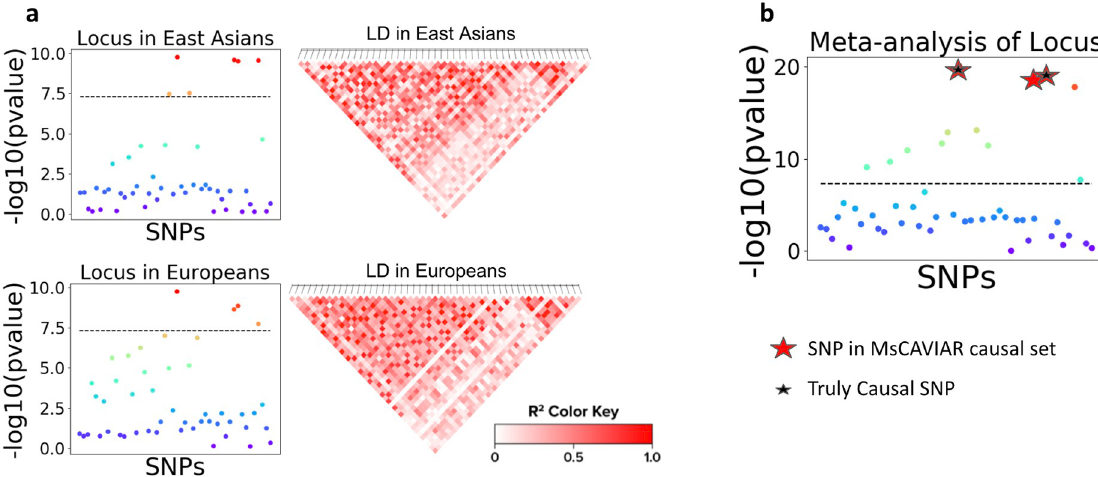
Fig 1. Overview of MsCAVIAR. (A) Simulated Z-scores for SNPs at a quantitative trait locus in two different populations: East Asians (top) and Europeans (bottom), shown by their − log 10 (p-value). LD matrices for these populations were derived using data from the 1000 Genomes project. These are the input files to MsCAVIAR. (B) Meta-analysis results for this locus, showing many significant SNPs. Also displayed are the SNPs that are in the causal set that MsCAVIAR returns (red stars) and the truly causal SNPs (black stars).